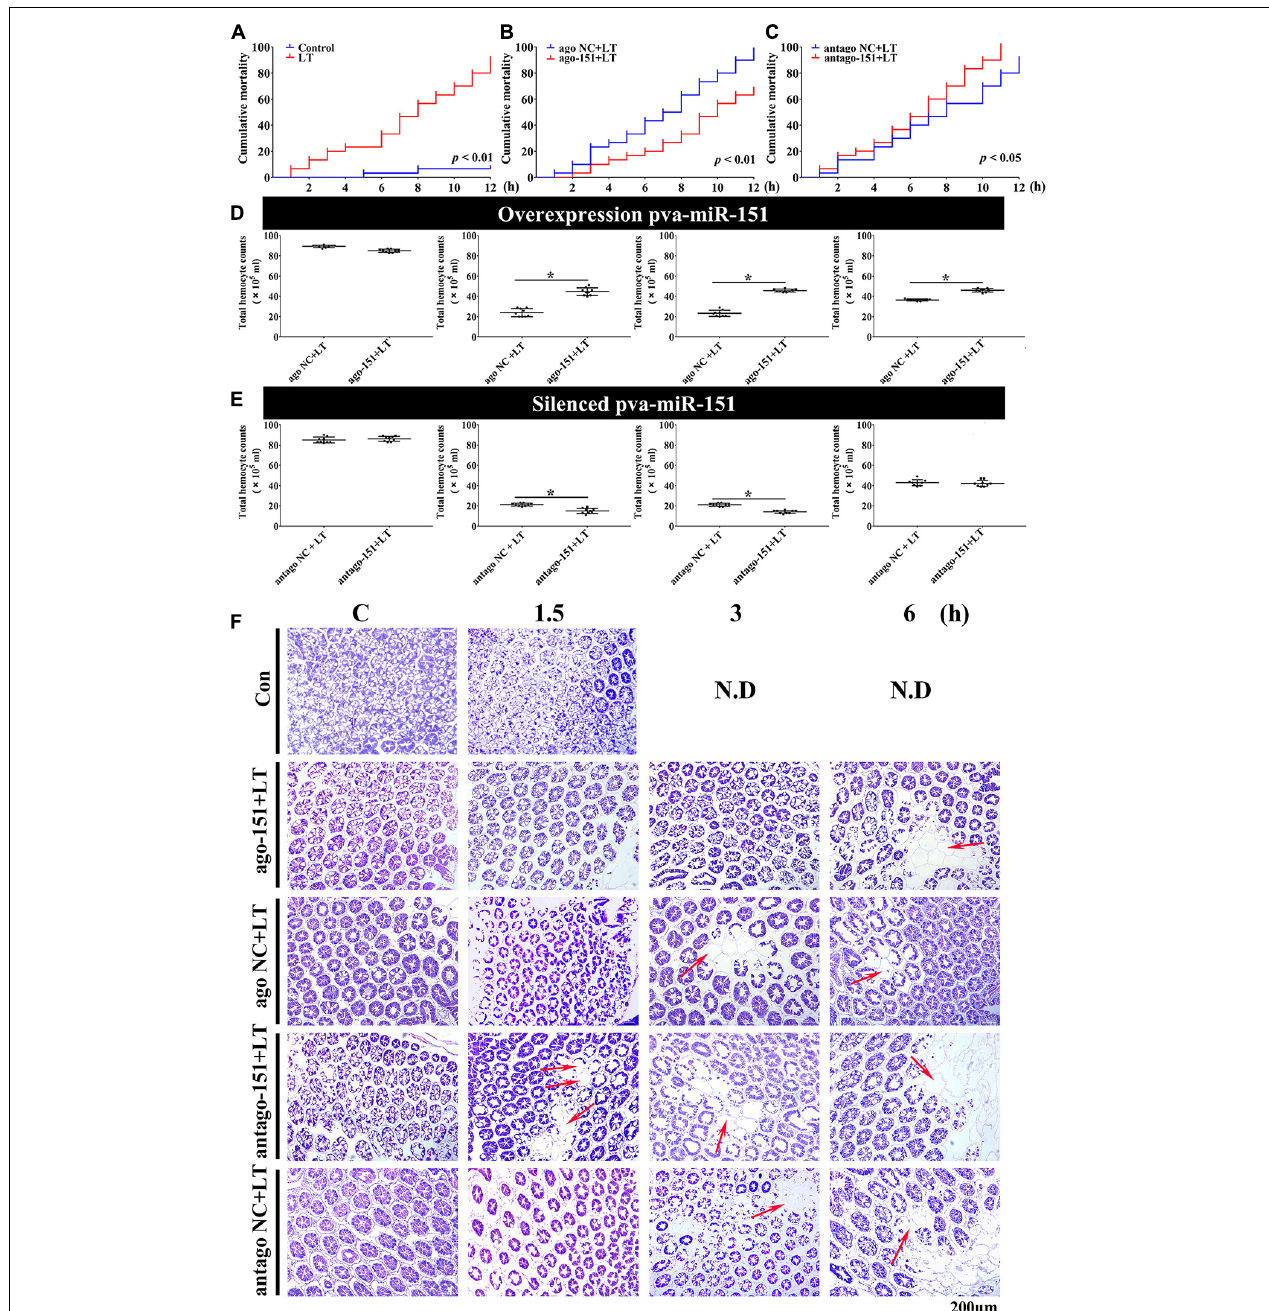
FIGURE 5 | Alterations of pva-miR-151 impact low-temperature tolerance of shrimp. (A) The shrimp were treated with low temperature at various times after challenge; the shrimp mortality was examined. In low temperature–challenged shrimp, mortality was reduced after pretreatment with ago-151 (B) and increased after pretreatment with antago-151 (C) . Differences in mortality curves between each group were analyzed by the log–rank test. THC was increased after pretreatment with ago-151 (D) and reduced after pretreatment with antago-151 (E) . Differences in THC between each group were analyzed by t test. *Significantly different ( p < 0.05). (F) H&E-stained hepatopancreas collected from ago-151, ago NC, antago-151, and antago NC groups after low-temperature challenge at 0–6 hpi. Pretreatment with ago-151 alleviates the vacuole cells, and cell atrophy occurred. ND, no data. Scale bar, 200 µ m.